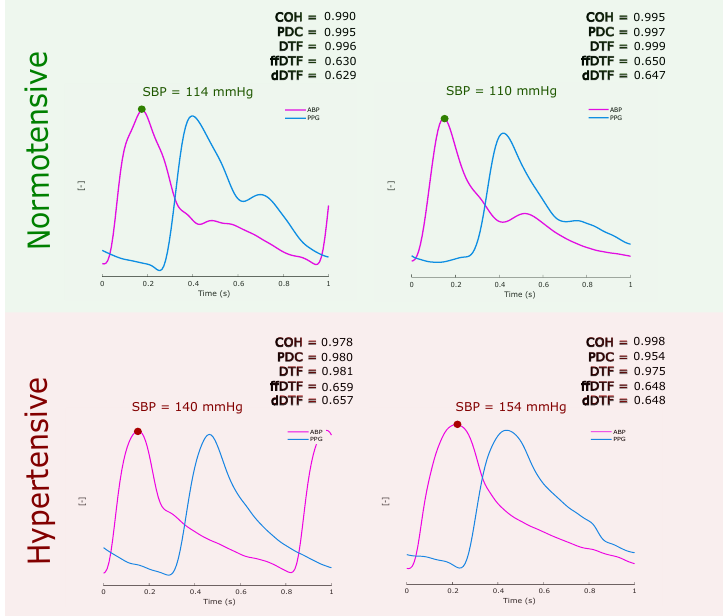
Figure 6. Examples of different causality measures for normotensive and hypertensive cases. Abbreviations: COH, Coherence; pCOH, Partial coherence; PDC, Partial directed coherence; DTF, Directed transfer function; dDTF, Direct directed transfer function; ffDTF, Full frequency directed transfer